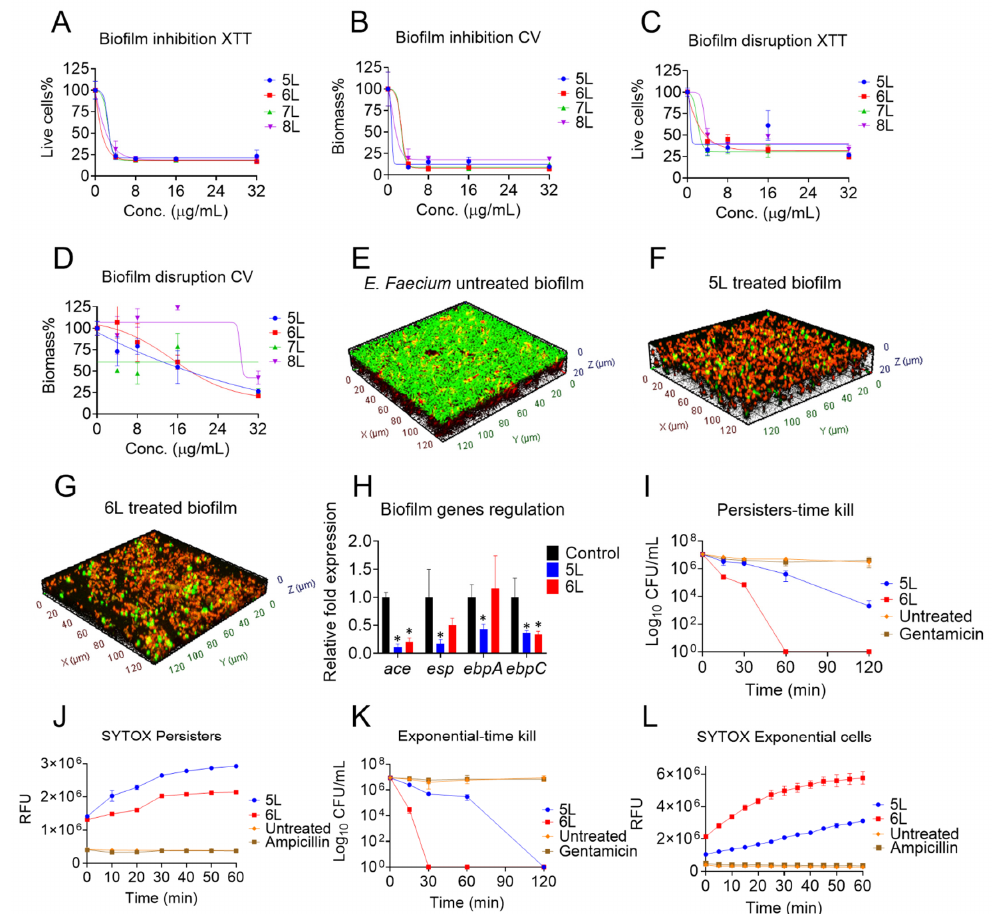
Figure 1. Antibiofilm and antipersister activity of designed LfcinB6 peptides against E faecium strain C68. ( A ) Inhibition of biofilm formation by peptides 5L–8L, live-cell reductions by XTT and ( B ) biomass by CV. ( C ) Disruption of 24 h established biofilms, live-cell reductions by XTT, and ( D ) biomass by CV. ( E ) Confocal microscopy of control E. faecium biofilm and ( F ) 5L- and ( G ) 6L- treated biofilms at 32 µ g/mL. ( H ) Key biofilm genes regulation by peptides 5L and 6L via real-time PCR (significant, * p < 0.05, determined by Student’s t -test) ( I ) The kinetic killing of E. faecium strain C68 persister cells by 5L and 6L at 10 × MIC. ( J ) SYTOX-based membrane permeabilization of persister cells by peptides 5L and 6L at 16 µ g/mL. ( K ) The kinetic killing of E. faecium strain C68